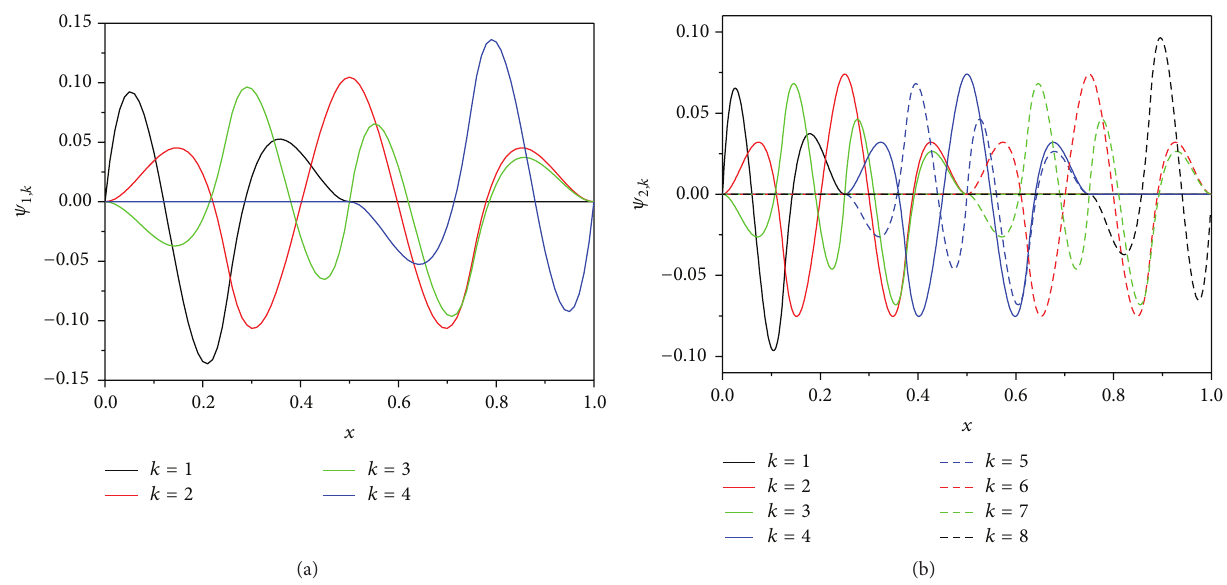
Figure 3: Wavelets in wavelet space 𝑊 : (a) wavelet in wavelet space 𝑊 1 and (b) wavelet in wavelet space 𝑊 2 .